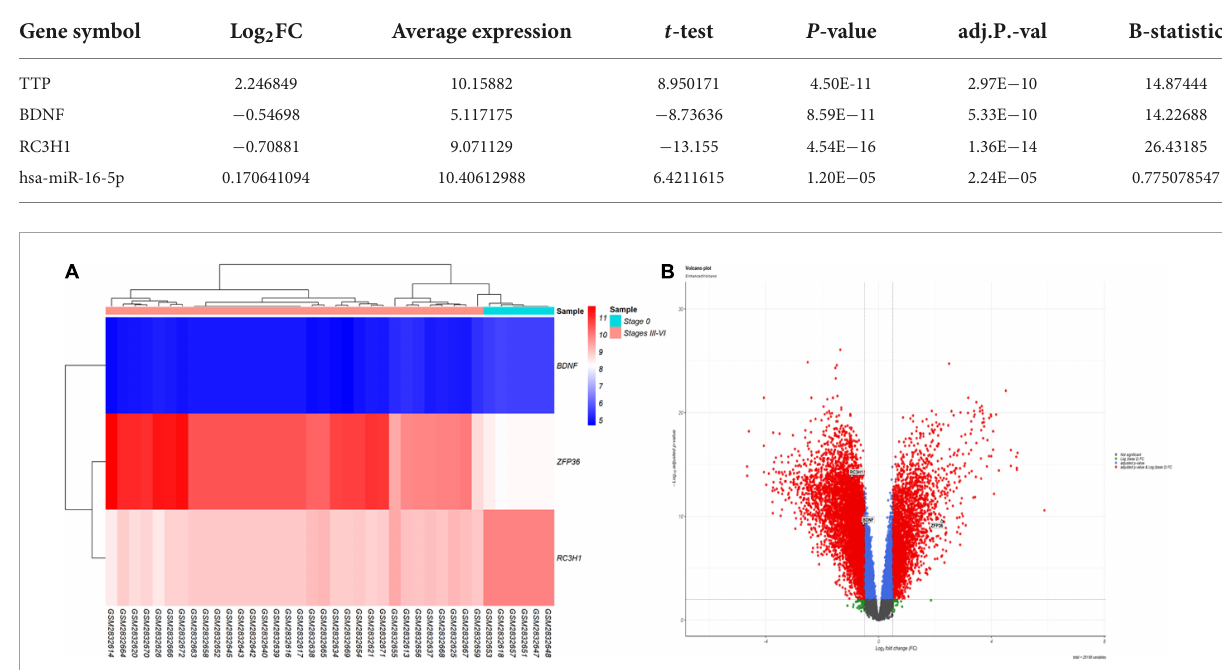
indicating a proper adjustment. MiR-16 has been